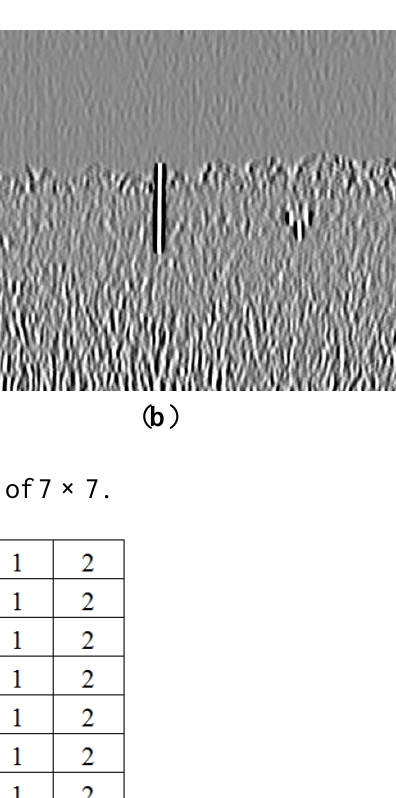
Figure 27. Comparison between ( a ) RGB and ( b ) 15 × 15 modified filtered excess green images with resolution of 1,008 × 672 on 1 July 2012.